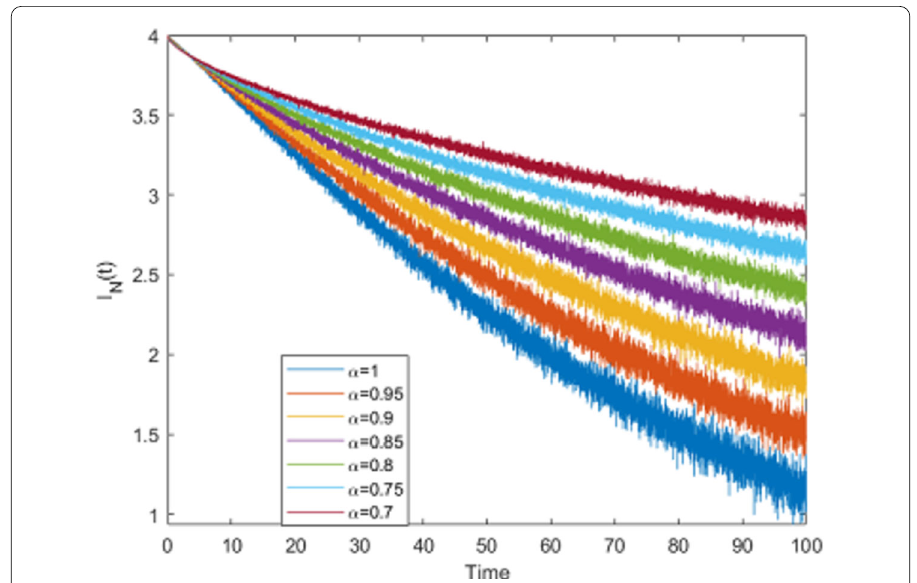
Figure 17 The class of researchers affected but with negative opinion for σ 4 = 0.00033